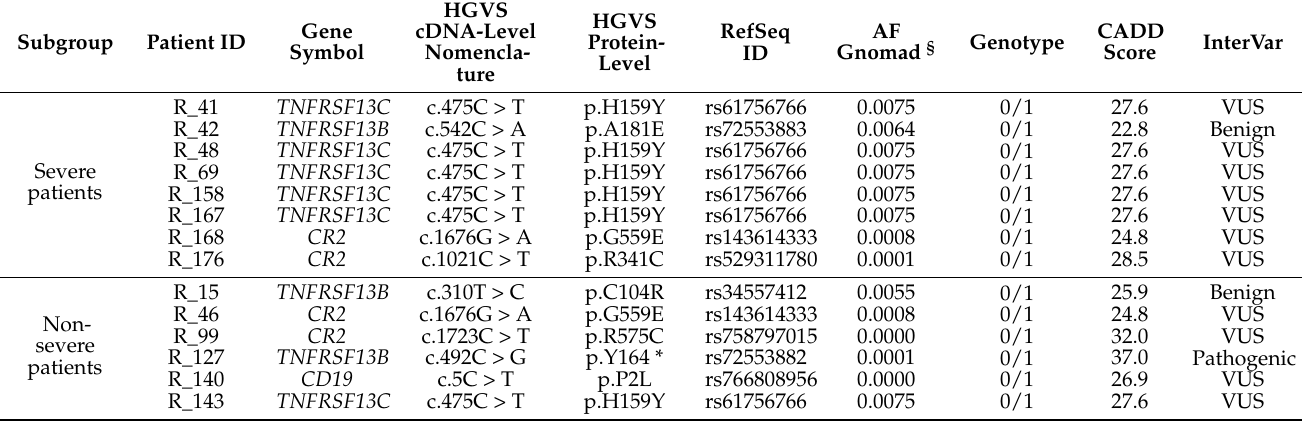
Table 3. Genetic variants identified in CVID-related genes.